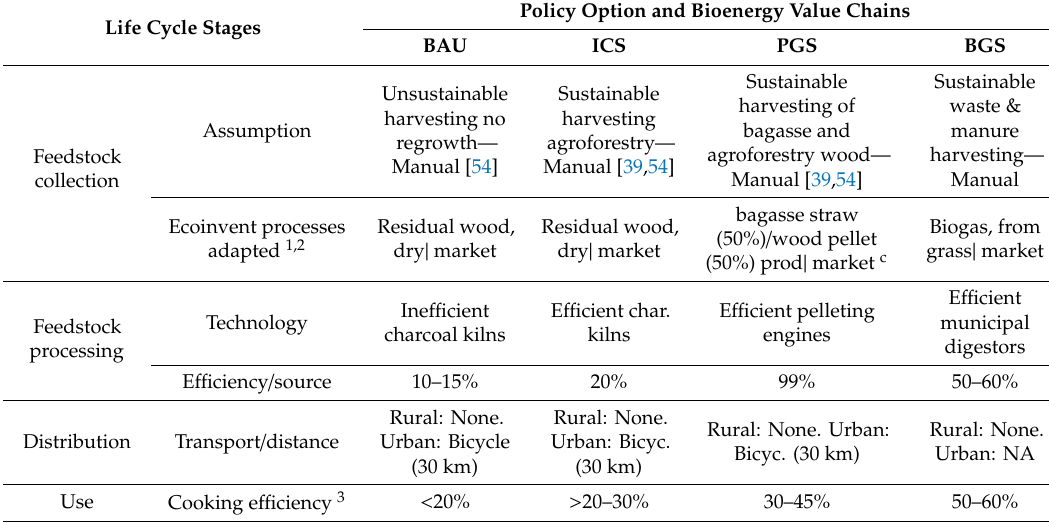
Table 2. Bioenergy value-chains for cooking, life cycle stages, assumptions, and source of data based on a previous scenarios established by Carvalho et al.